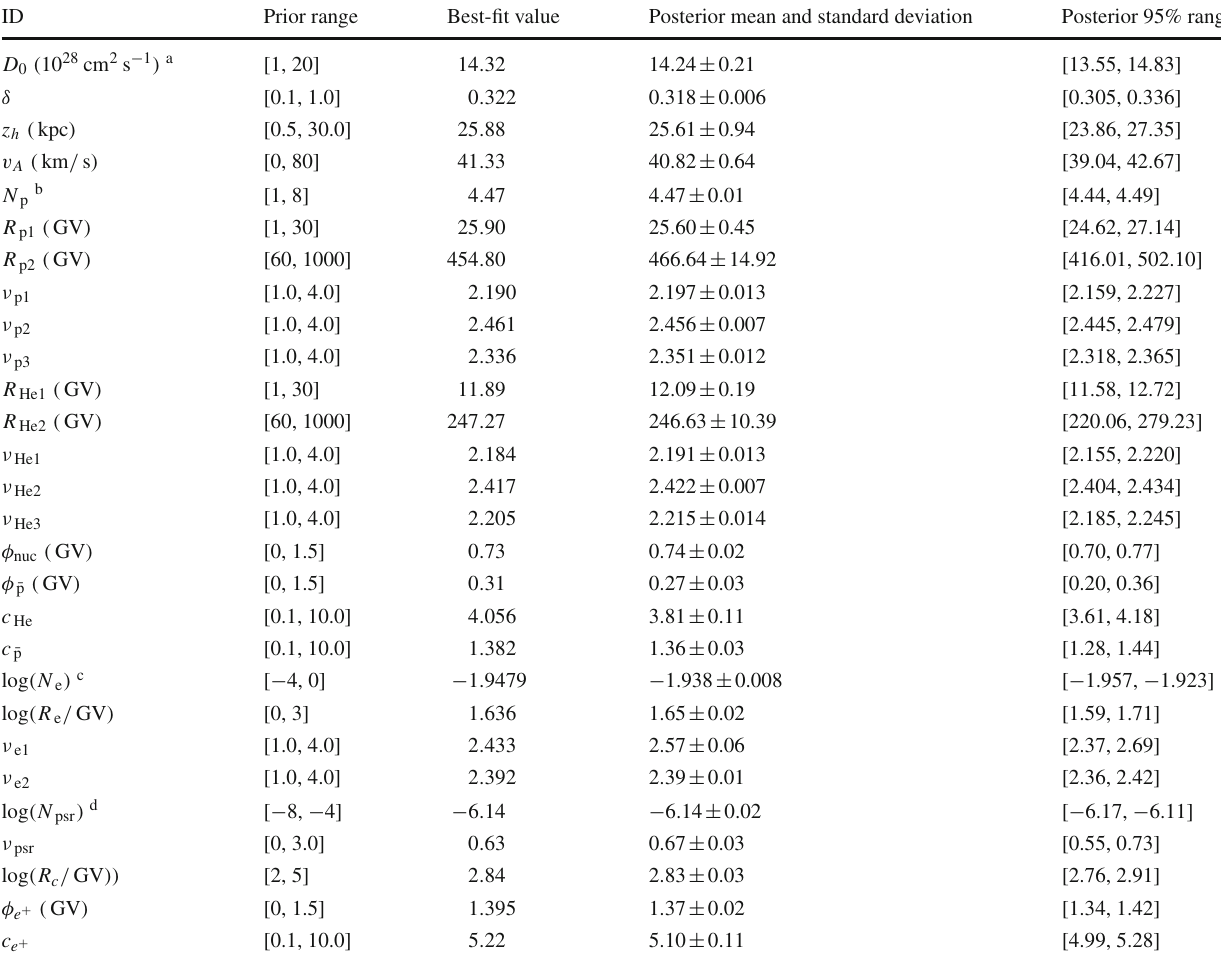
Table 2 Constraints on the parameters of DAMPE CREs spectrum, pulsar scenario. The prior interval, best-fit value, statistic mean, standard deviation and the allowed range at 95% CL are listed for the parameters. For the best-fit values, we have χ 2 / d . o . f . = 243 . 13 / 299 ID Prior